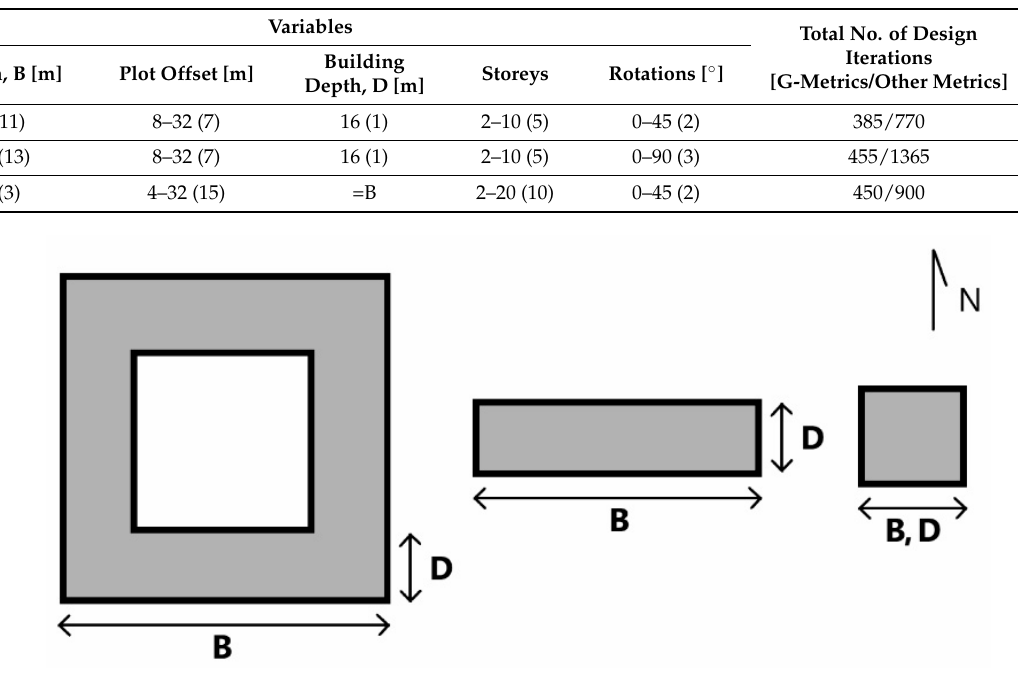
Table 1. Range (X-Y) and number (N, in brackets) of discrete variables used in neighbourhood de- sign iterations and the total number of iterations.